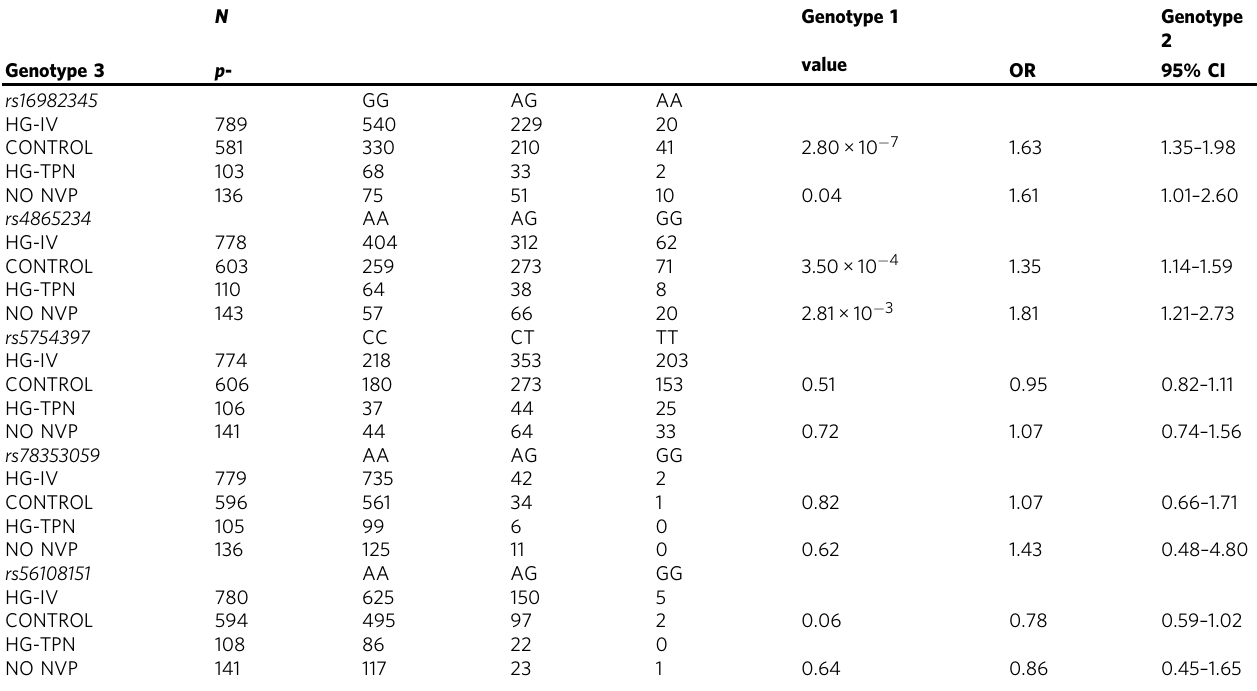
Table 6 Replication results based on Fisher ’ s exact test for the two most signi fi cantly associated loci in SCAN1 and SCAN2: rs16982345 (chr19p13.11), rs4865234 (chr4q12), and the three association signals in SCAN1 with p > 5 × 10 − 8 and p < 1 × 10 − 6 ,